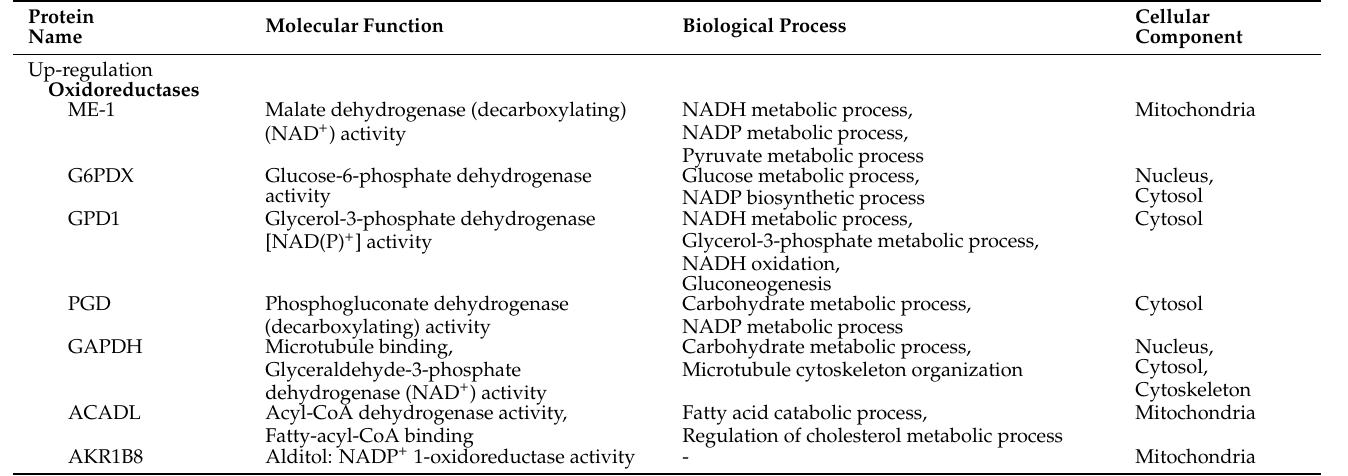
Table 3. Functional properties and location of epididymal adipose tissue proteins of 6-week-old CP that showed significant changes in their expression